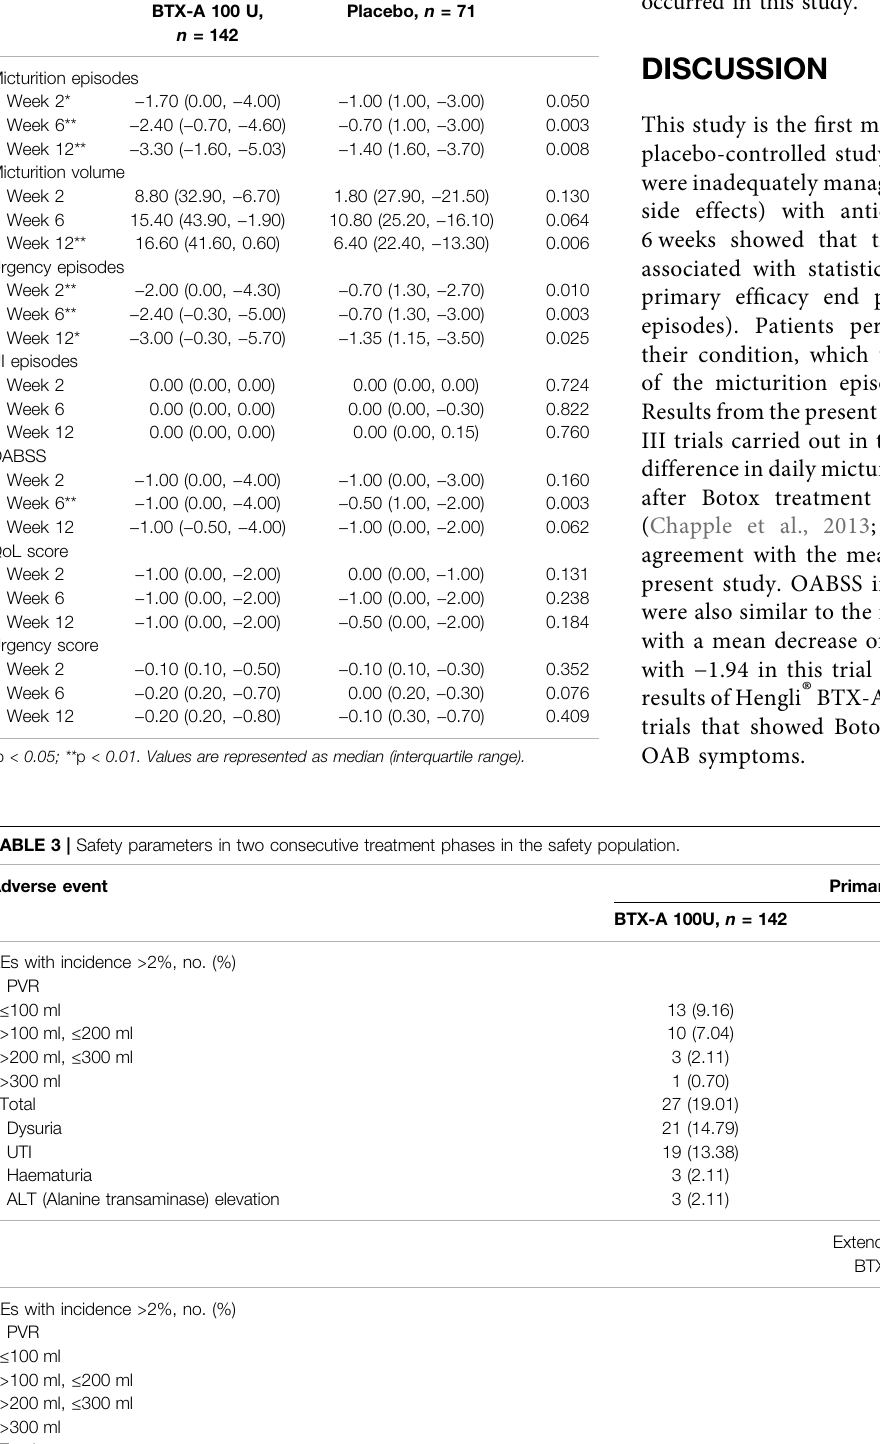
TABLE 2 | Change from baseline in daily average episodes up to post-treatment week 12 in FAS population. Mean change from baseline